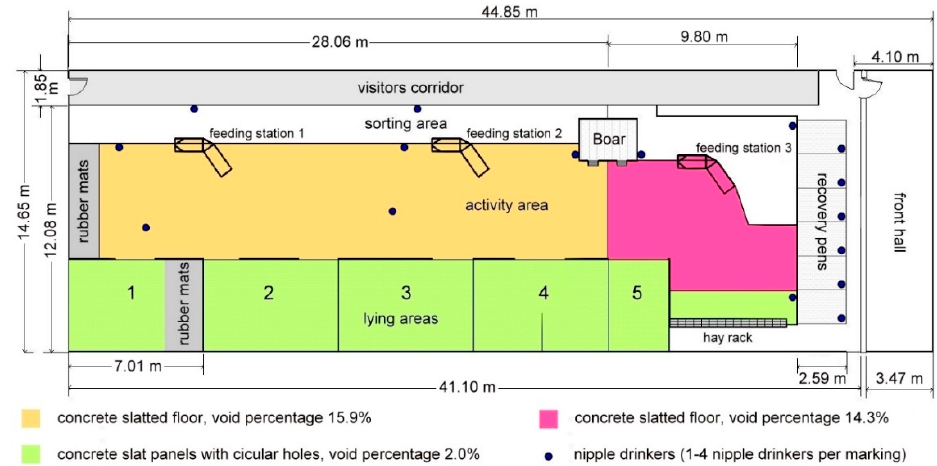
Figure 1. Situation during the experiment in the waiting house at the research centre 'Haus Düsse'.